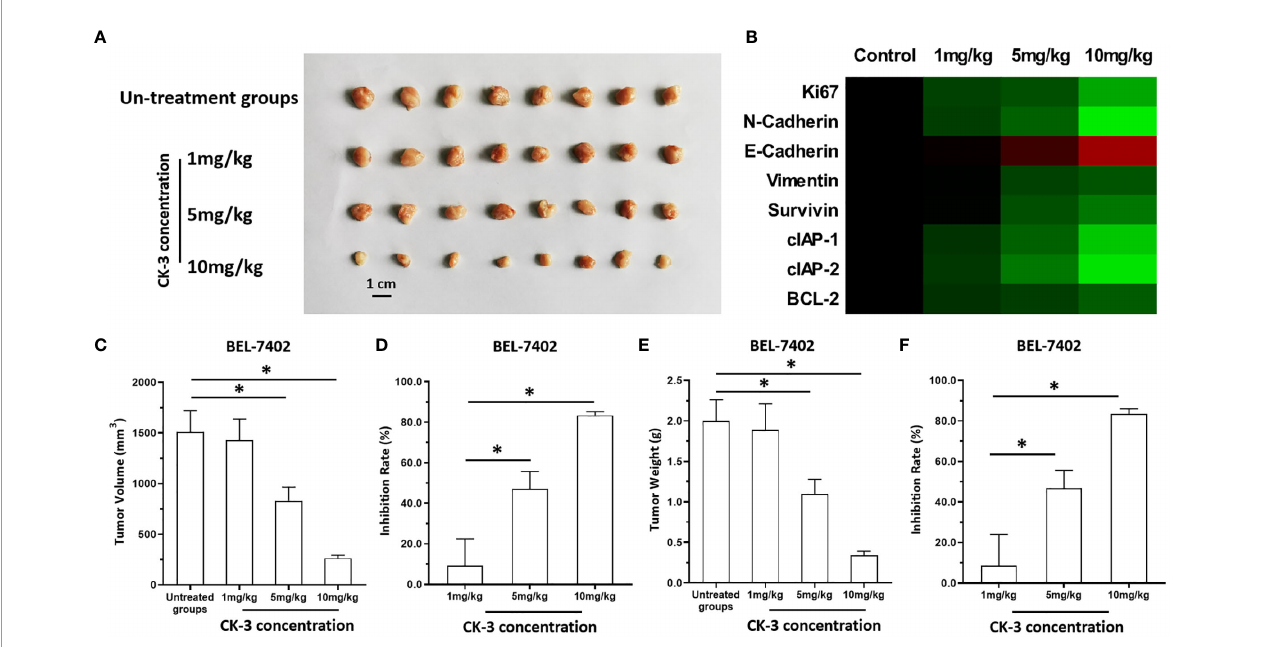
FIGURE 6 | The in vivo antitumor activation of CK-3. BEL-7402 was cultured and injected in to the subcutaneous position of the nude mice. Mice were received the CK-3 via oral administration. The results were shown as the images of tumor tissues (A) , the heat-map indicated the inhibitory rates of CK-3 on proliferation, pro- survival, anti-apoptosis or EMT related factors (B) , tumor volumes (C) , inhibitory rates of CK-3 according to tumor volumes on Bel-7402 (D) , tumor weights (E) , inhibitory rates of CK-3 according to tumor weights on Bel-7402 (F) . *P <